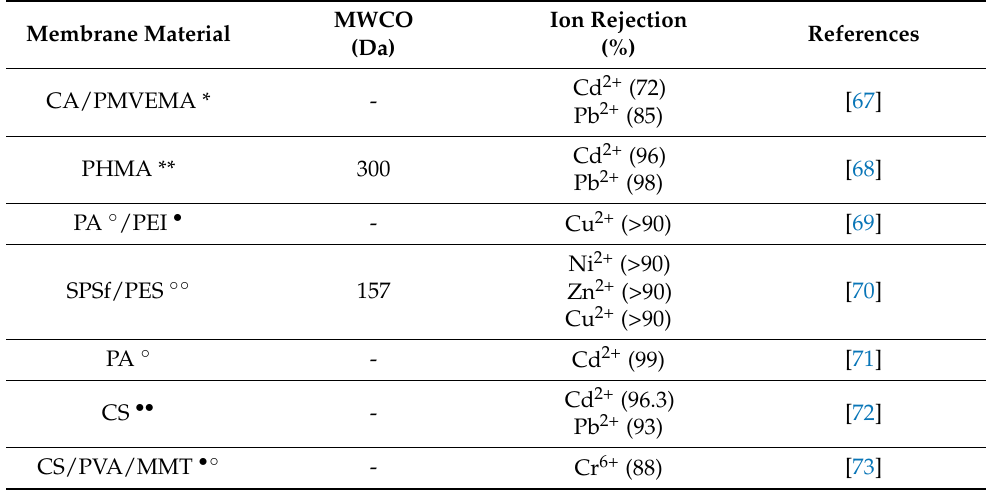
Table 9. NF membranes used for the removal of metal